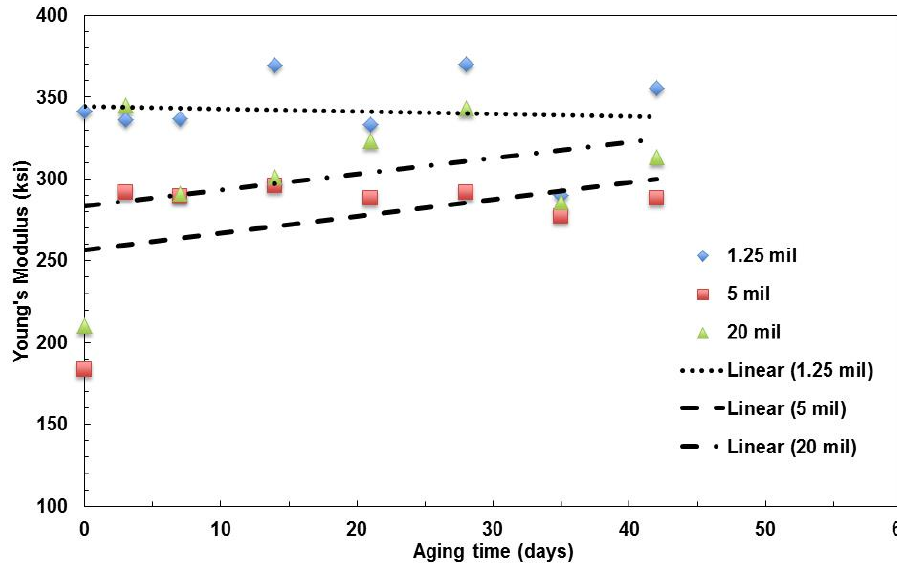
Figure 5. Summary of the change in Young’s modulus with aging time for films with various film thicknesses aged at 100 °C.